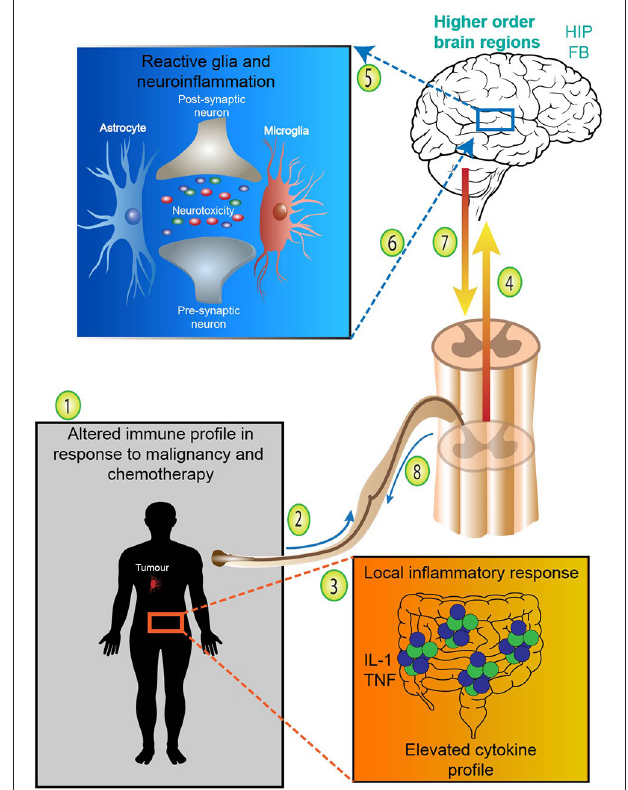
FIGURE 2 | Adapted from Dodds et al. (2016). Neuroimmunological complications arising from cancer and chemotherapy treatment. (1) Cancer patients undergoing chemotherapy treatment express an altered immune profile with increases in proinflammatory cytokines. (2) Systemic proinflammatory cytokines and mediators, such as IL-1 and TNF released either from the malignancy or treatment-associated toxicities access the brain directly via leaky circumventricular organs or (3) indirectly via neural transmission. (4) Systemic or localized proinflammatory mediators and cytokines signal higher order brain regions and (5) activate microglia and astrocytes. Reactive glia undergo morphological changes and overproduce proinflammatory mediators whilst reducing anti-inflammatory output—resulting in neurotoxicity and neuroinflammation. (6) In particular brain regions primed glia and neuroinflammation influence behaviors involving cognition and contribute to various neurodegenerative diseases. (7) Centrally derived neurogenic inflammation and descending signaling in the spinal cord (8) contributes to the exacerbation of peripheral inflammatory conditions and exaggerated pain states. Therefore, peripheral-to-central innate immune signaling represents a plausible mechanism meditating chemotherapy-induced gut toxicity and neurological changes. FB, forebrain; HIP, hippocampus; IL-1, interleukin-1; TNF, tumor necrosis